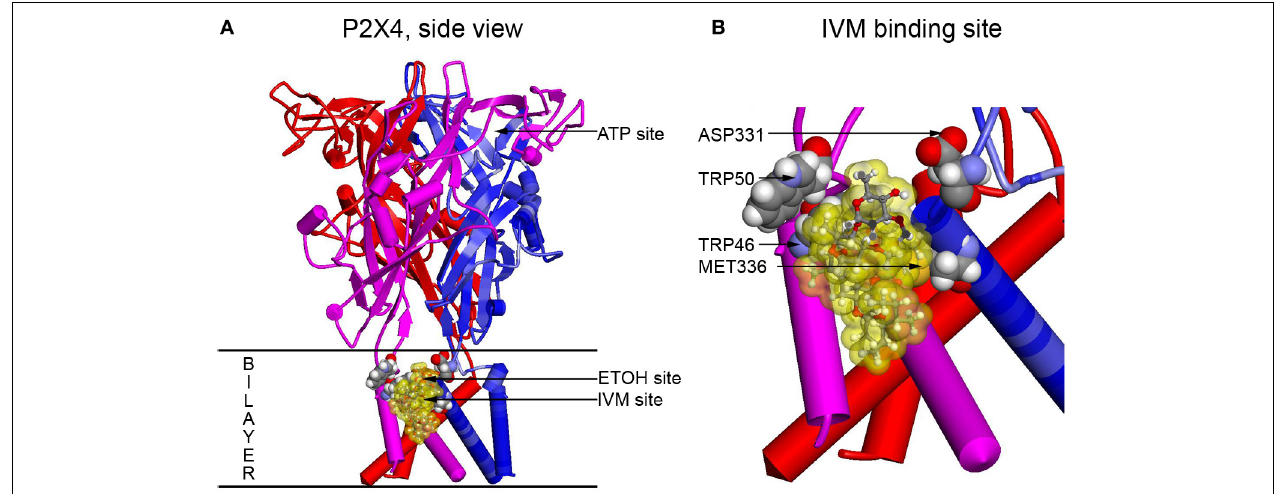
FIGURE 2 | Full size and zoomed models of the rat P2X4R. A homology model of rat P2X4R was built by threading the rat primary sequence on the zebrafish X-ray structure in the open conformation (PDB ID 4DW1) (Hattori and Gouaux, 2012), essentially as described before (Popova et al., 2013). (A) A side view of the full P2X4R as viewed in the plane of the membrane looking toward the ion pore from the outside. Horizontal lines indicate the predicted extent of the membrane bilayer. The ATP binding site is over 20 Angstroms distant from the IVM binding site, yet there is substantial interaction between them. Residues